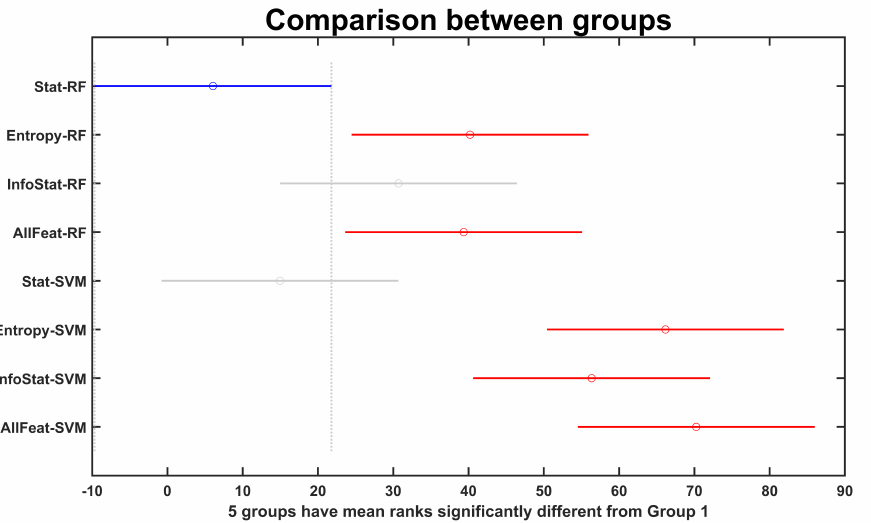
Figure A2. Kruskal–Wallis comparison between the machine learning models tested, considering several combinations of features extracted from the channel A1 of the RC dataset. There are statistical significant differences between the groups labeled with red and the group labeled with blue. In general there are statistically significant differences, when the projection of the horizontal lines of a group over the horizontal axis does not have any interception with the projection of another